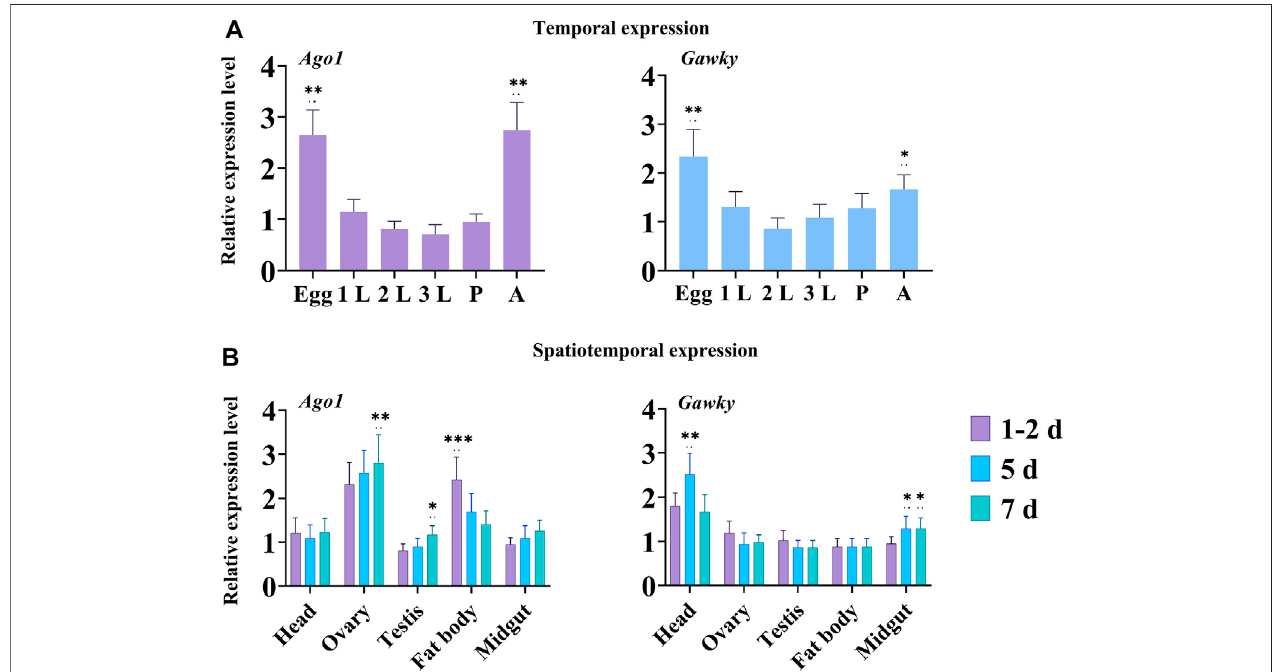
FIGURE 2 | Temporal and spatial expression of Ago1 and Gawky in Z. cucurbitae. (A) Relative expression levels of Ago1 and Gawky genes in different developmental stages. Egg,1 st instarlarvae(1L), 2 nd instarlarvae (2L), 3 rd instar larvae(3L), pupae (P), and adult(A). (B) Relative expression levelsof Ago1 and Gawky in different tissues. Samples were collected from the head, ovary, testis, fat body, and midgut of ten fl ies at 1 – 2 days old, and of eight fl ies at 5 and 7 days old in each replicate.Thebarsrepresent2 – ΔΔ CT values(±SD)normalized tothegeometricalmeanoftheexpression oftwohousekeepinggenes.Theasterisksabove thebars designate signi fi cant differences (* p < 0.05; ** p < 0.01; *** p ≤